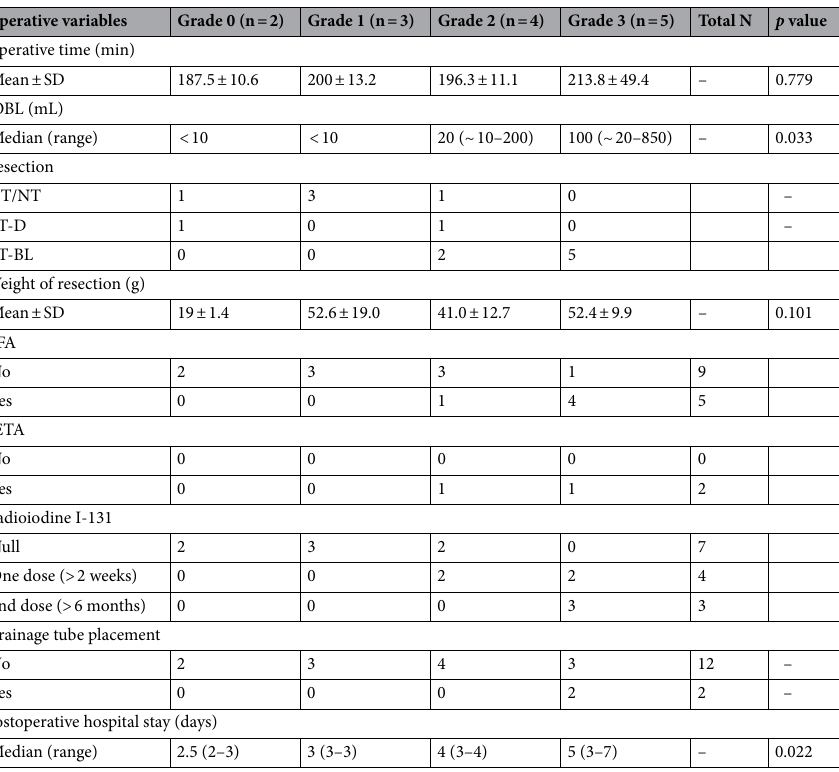
Table 2. Operative variables according to goiter size grade. Data are presented as number of patients, unless otherwise noted. SD standard deviation, IOBL intraoperative blood loss, TT total thyroidectomy, NT near-total